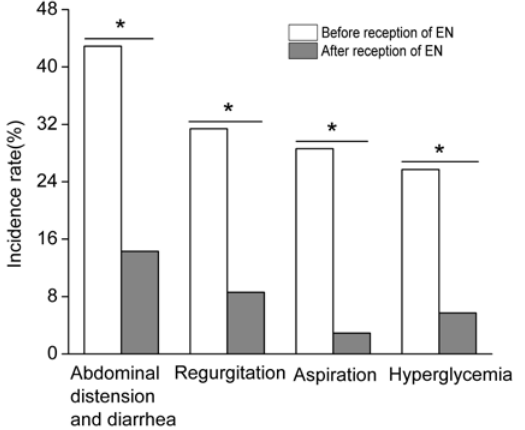
Figure 3: The incidence of bloating & diarrhea, reflux, aspiration, and hyperglycemia in the nasointestinal tube group was signifi- cantly lower than that in the nasogastric tube